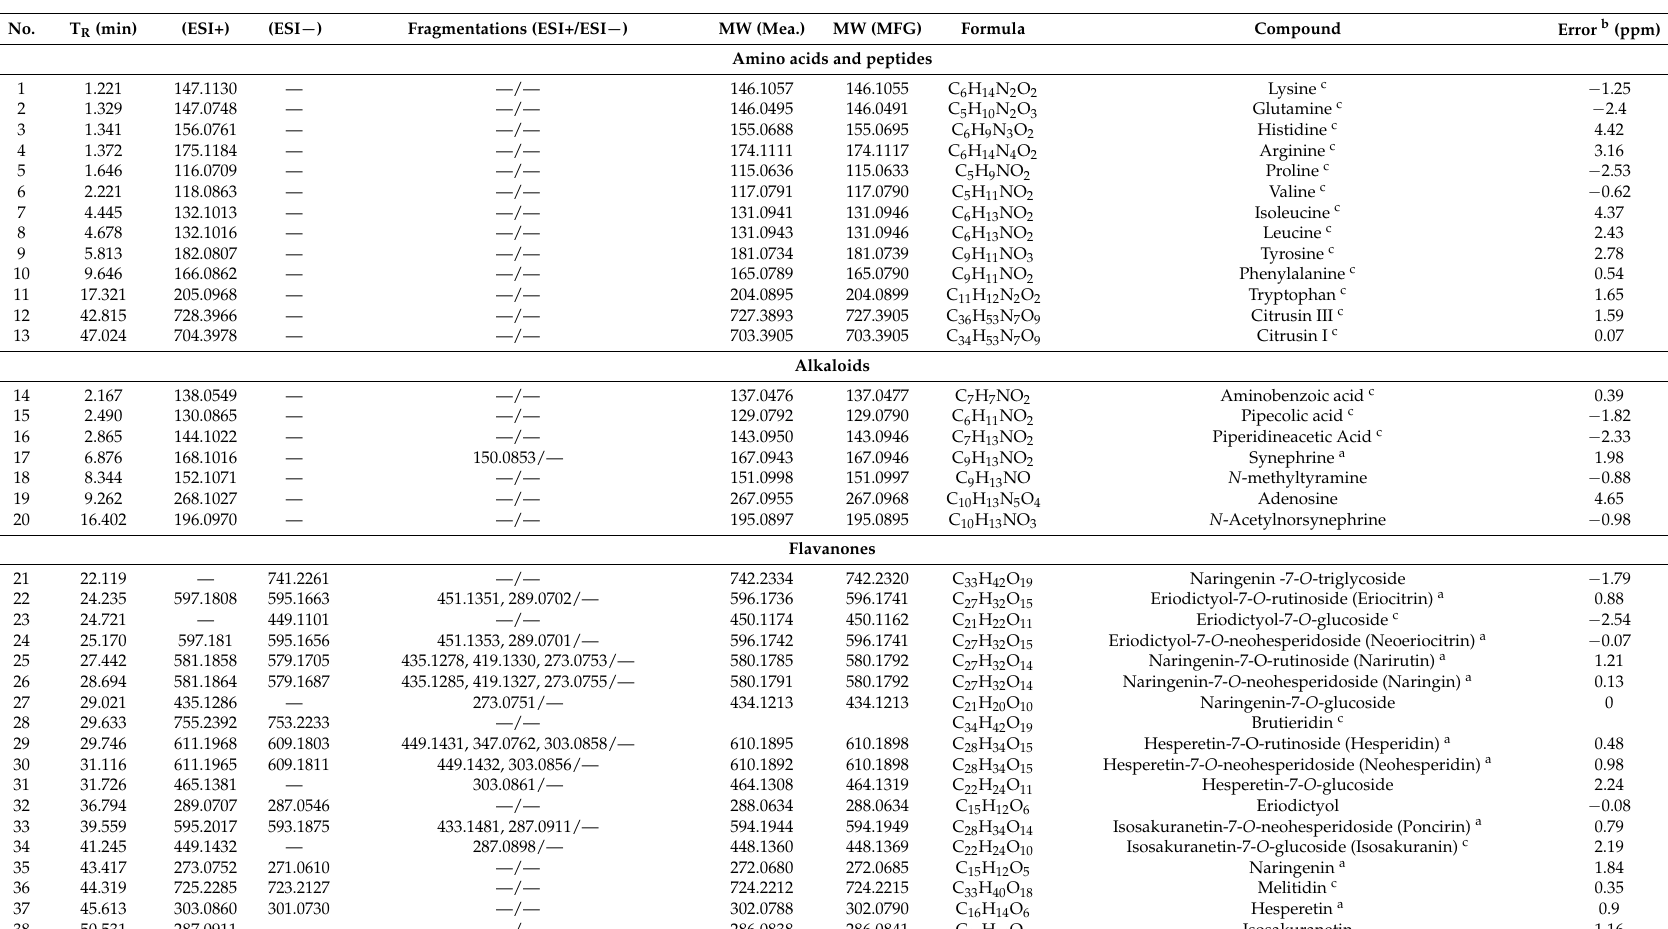
Table 1. Identification of constituents from Aurantii fructus by the high-performance liquid chromatography quadrupole time-of-flight mass spectrometry method in positive and negative ion